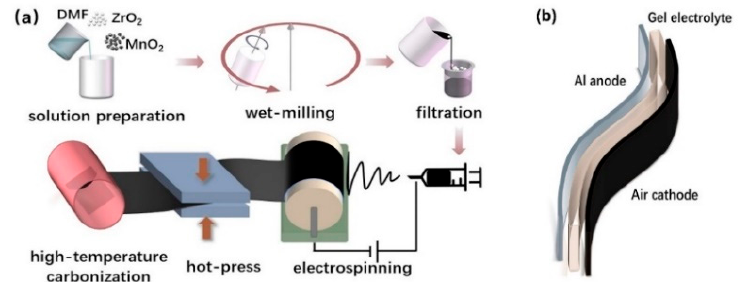
Figure 1. ( a ) Schematic illustration of the fabrication of air cathodes by directly electrospinning. ( b ) Sandwich structure of the Al-air battery.